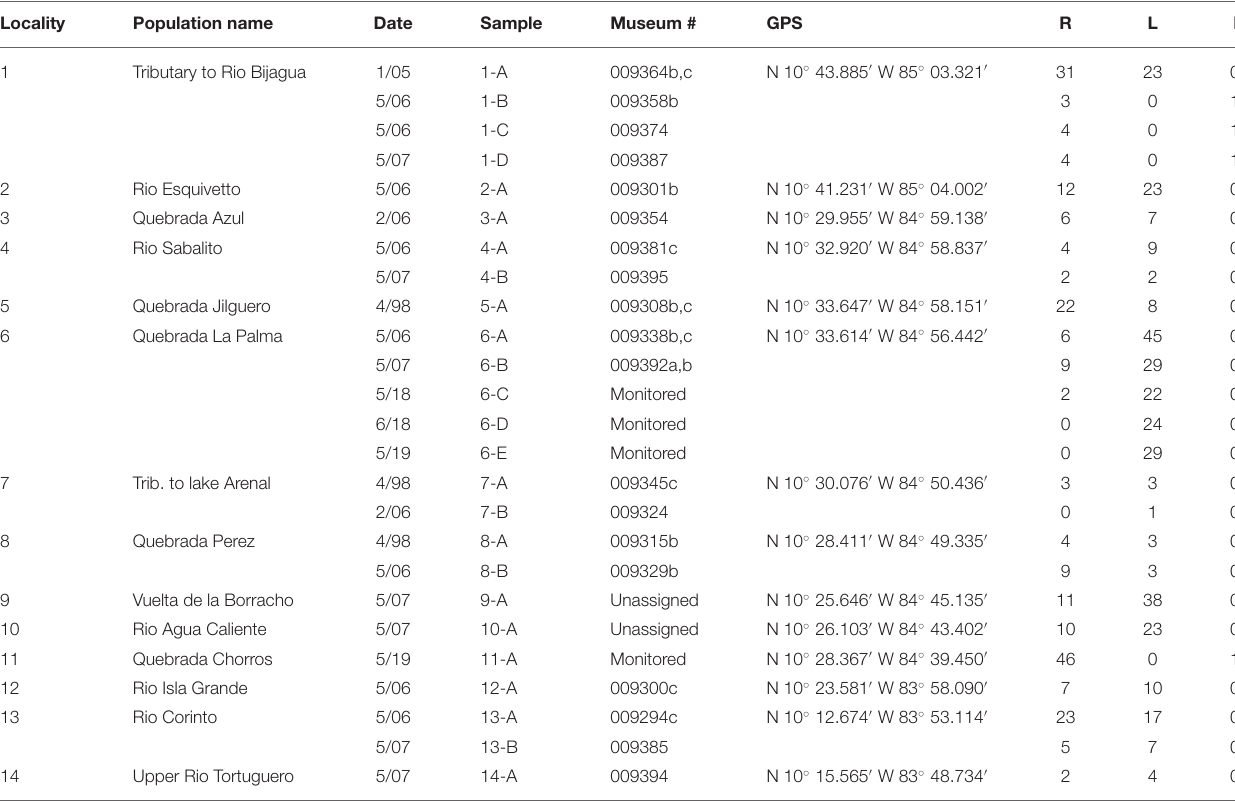
Locality numbers correspond to those found on the map in Figure 2 . Date depicts the month/year that the collection was made; where multiple collections were made from the same locality, they are designated by a letter. The museum # indicates the population accession number in the Brigham Young University Monte L. Bean Life Science Museum (MLBM); “Monitored” indicates populations where fish were collected, scored, and returned unharmed to the stream; “Unassigned” indicates samples that have yet to be assigned a number in the MLBM. R and L show the number of individual males with a right morph and left morph gonopodium, respectively, from each sample. R:L indicates the right to left morph